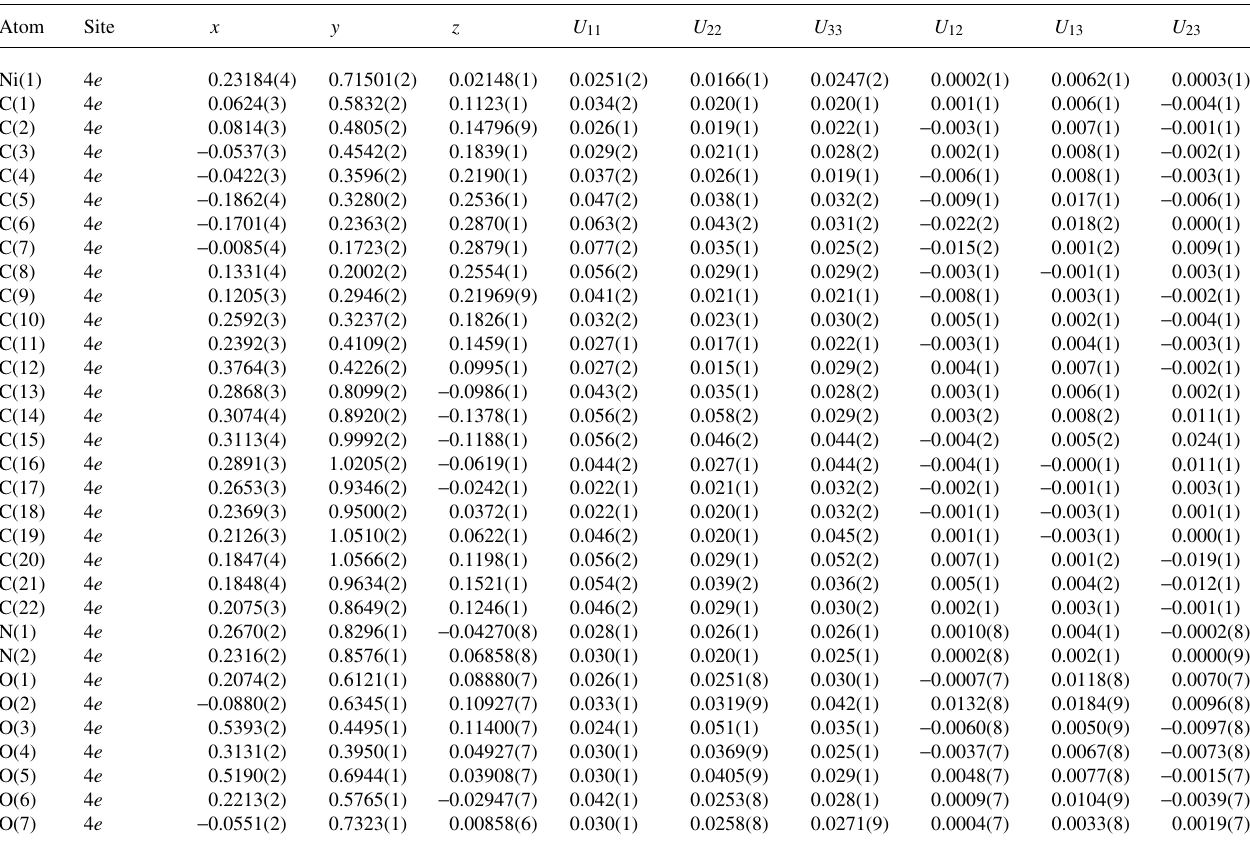
Table 3. Atomic coordinates and displacement parameters (in Å 2 )